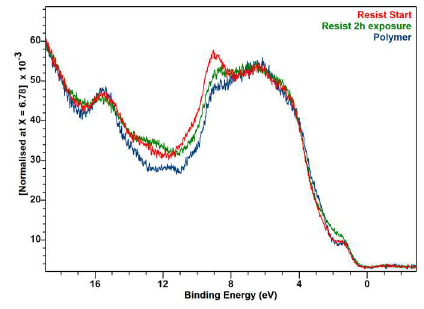
Figure 7 : UPS spectra from a non-exposed polymer-based resist (red), the base polymer (blue) and the exposed resist